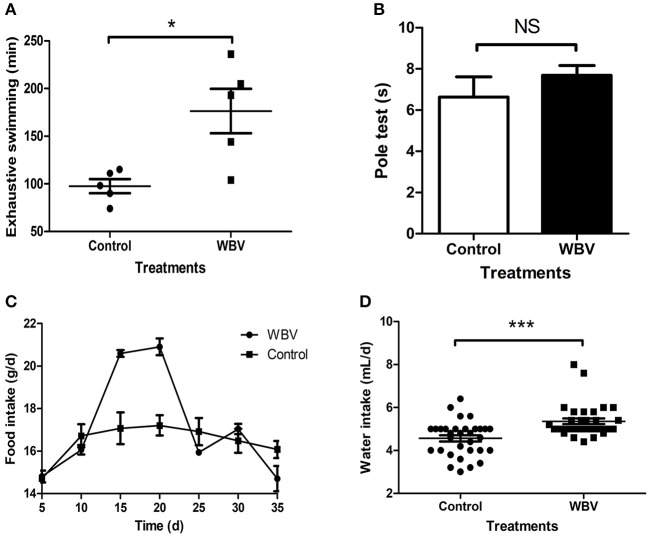
WBV did not cause any movement disorder or other changes in behavior. The Exhaustive swimming (A) results exhibited a significant difference between the mice with vibration or not, but the Pole test (B) results showed no difference; (C,D) the food and water intake of the mice. NS, not significant; *p < 0.05; ***p < 0.001.